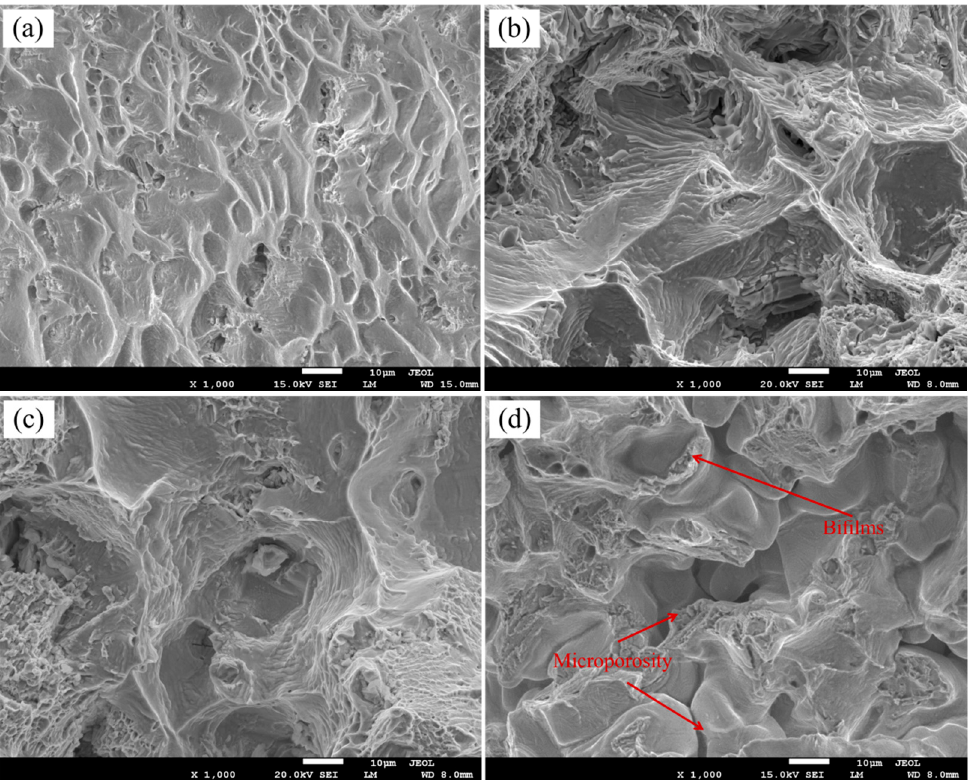
Figure 12. SEM micrographs showing the typical fracture on the tensile specimens ( a ) 3 mm; ( b ) 6 mm; ( c ) 12 mm; and ( d ) 24 mm.